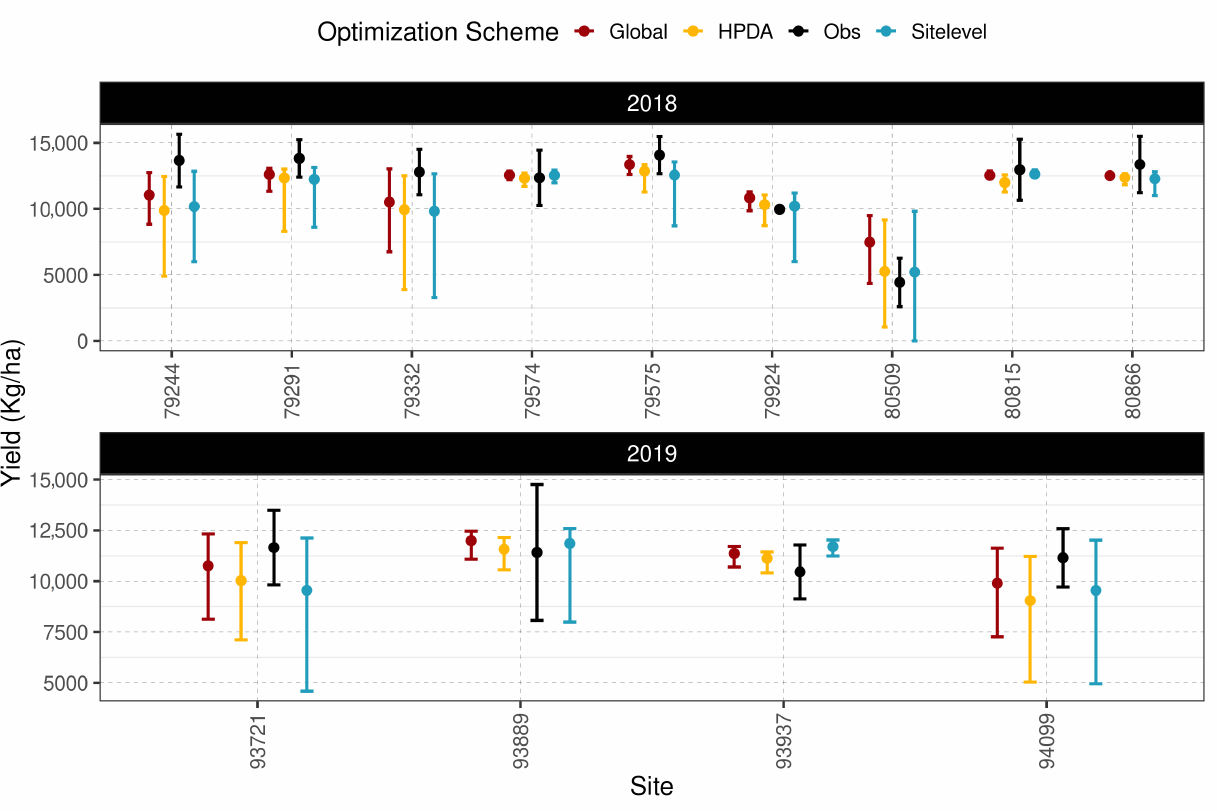
Figure 7. 95% Confidence interval for within sample yield comparison between different optimization